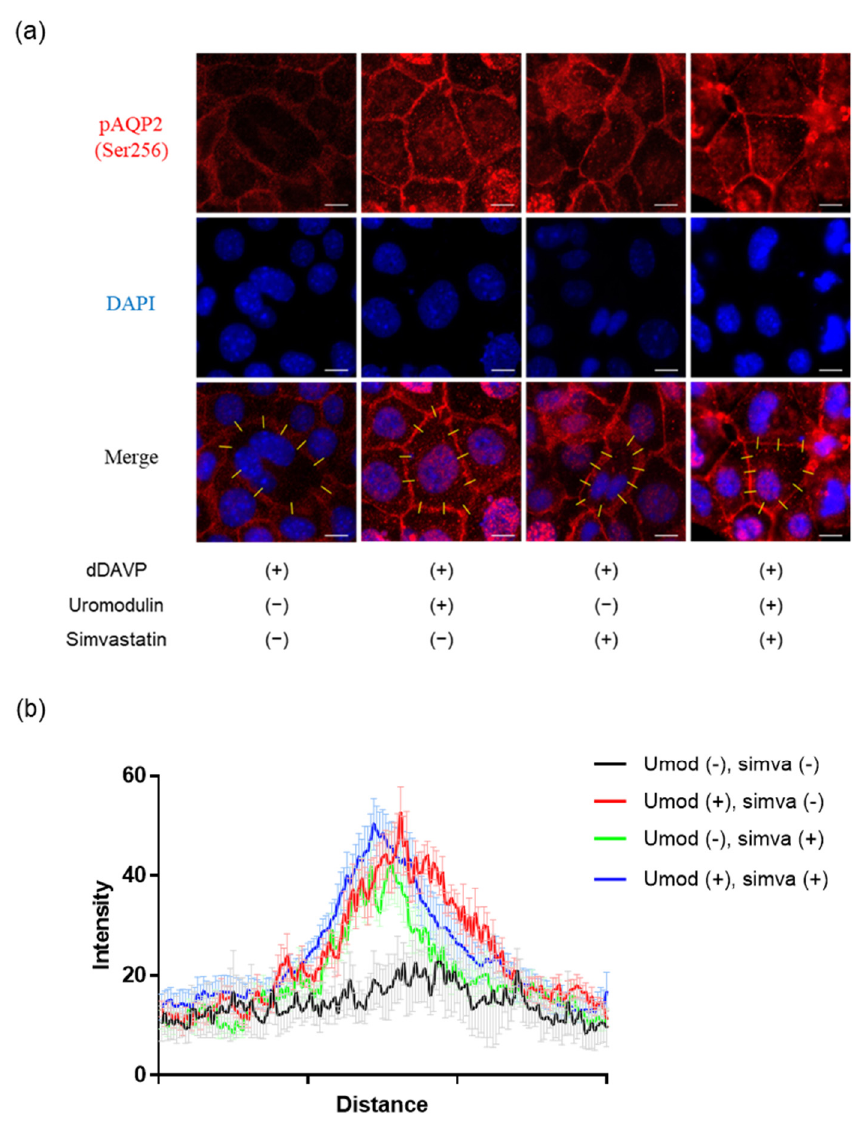
Figure 7. Uromodulin may activate AQP2 through the suppression of endocytosis. ( a ) Representative immunofluorescence images for Ser256 − phosphorylated AQP2 in mouse collecting duct cells treated with 10 − 9 M dDAVP with or without 10 − 6 µ g/mL uromodulin and 100 µ M simvastatin for 24 h. Uromodulin-treated cells showing strong signals for phosphorylated AQP2 (red). Strong linear signals for phosphorylated AQP2 at the membrane can be observed in cells treated with simvastatin, regardless of uromodulin treatment. ( b ) Intensity profiles for Ser256-phosphorylated AQP2 along axis across the cell membrane. Quantifications are based on ten axes (yellow lines) in each condition and showed as mean and SEM. Bars indicate 10 µm. DAPI, 4’,6 − diamidino − 2 − phenylindole; umod, uromodulin; simva, simvastatin.